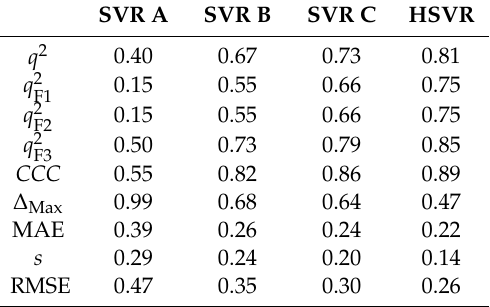
, q 2 , and q 2 , concordance correlation F1 F2 F3 SVR A SVR